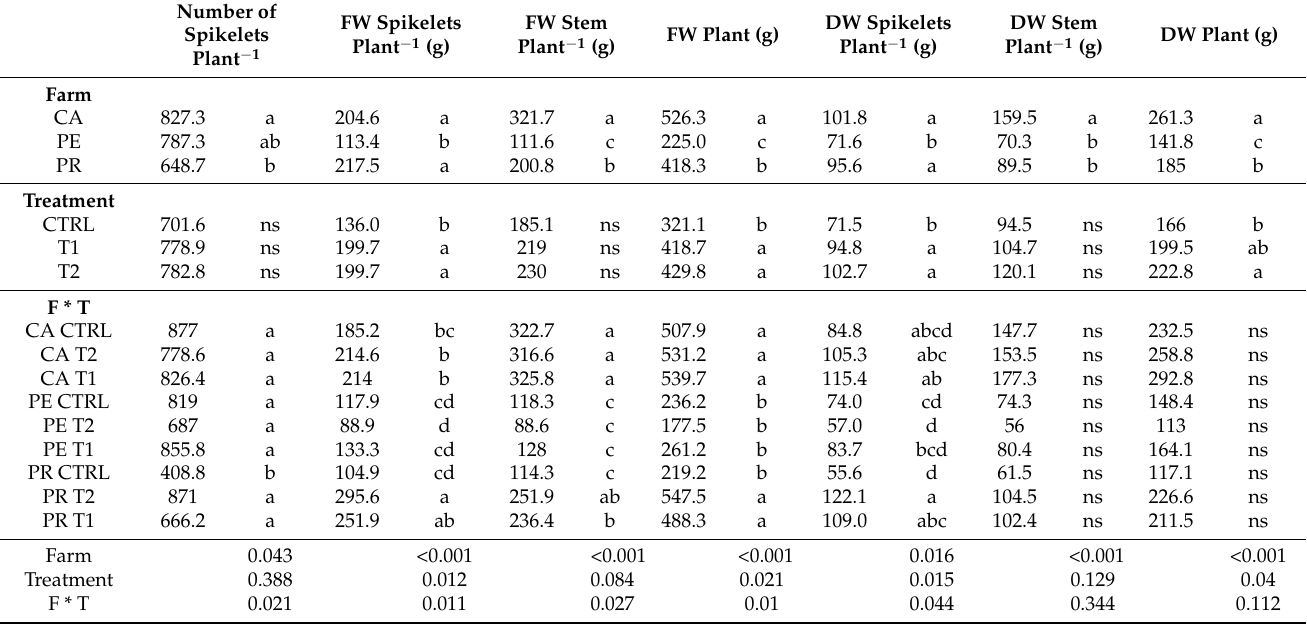
Table 2. Result of the ANOVA test performed on the morphological parameters from 2020/2021. a–d means followed by different letters are statistically significant at p < 0.05; ns, not significant. FW, fresh weight; DW dry weight; F * T, farm * treatment interaction. CA, Campazzo; PE, Pedroni; PR, Preci; CTRL, control with foliar application of tap water; T1, foliar application of FITOSTIM; T2, foliar application of FITOSTIM